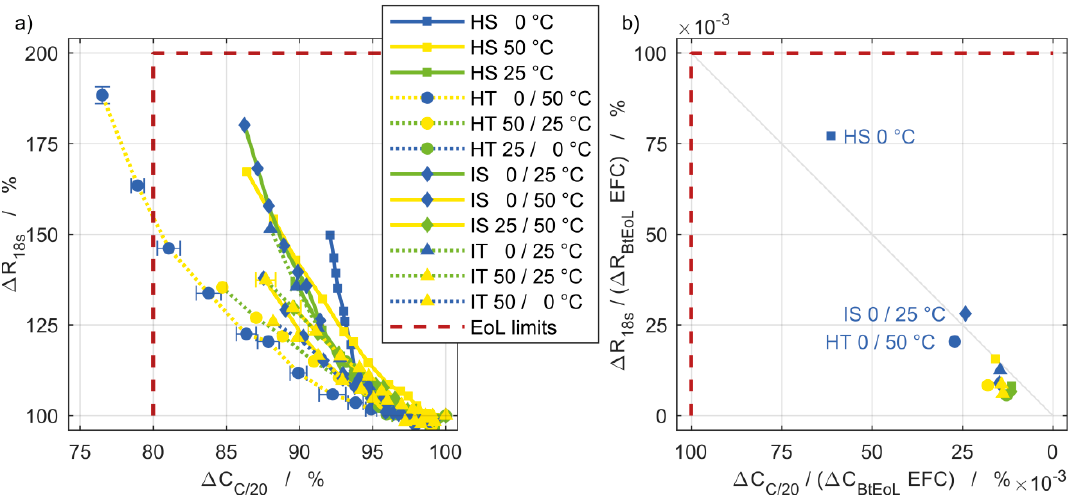
Figure 6. ( a ) Power fade in terms of current pulse resistance degradation versus capacity fade and ( b ) normalized to the threshold values indicated in red and in relation to the number of EFC.